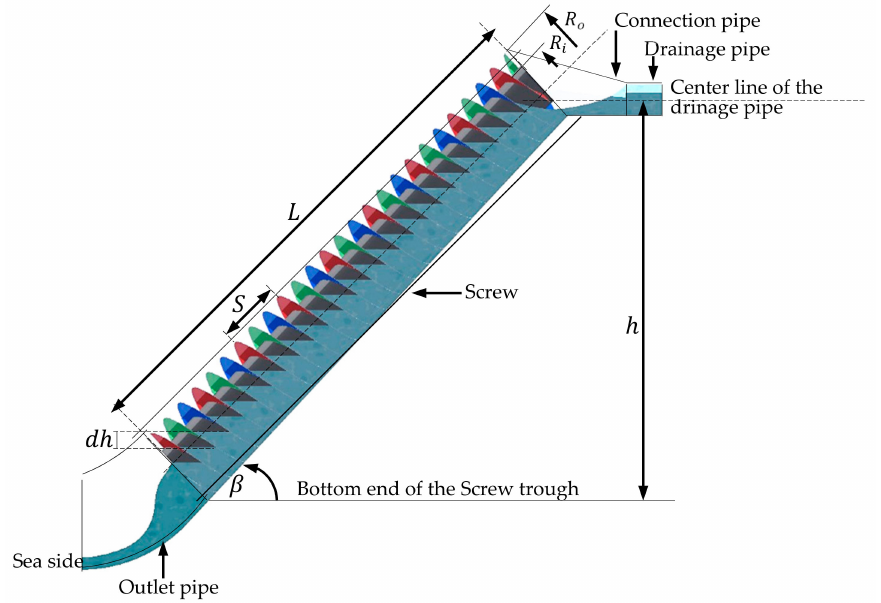
Figure 3. Internal and external parameters of the